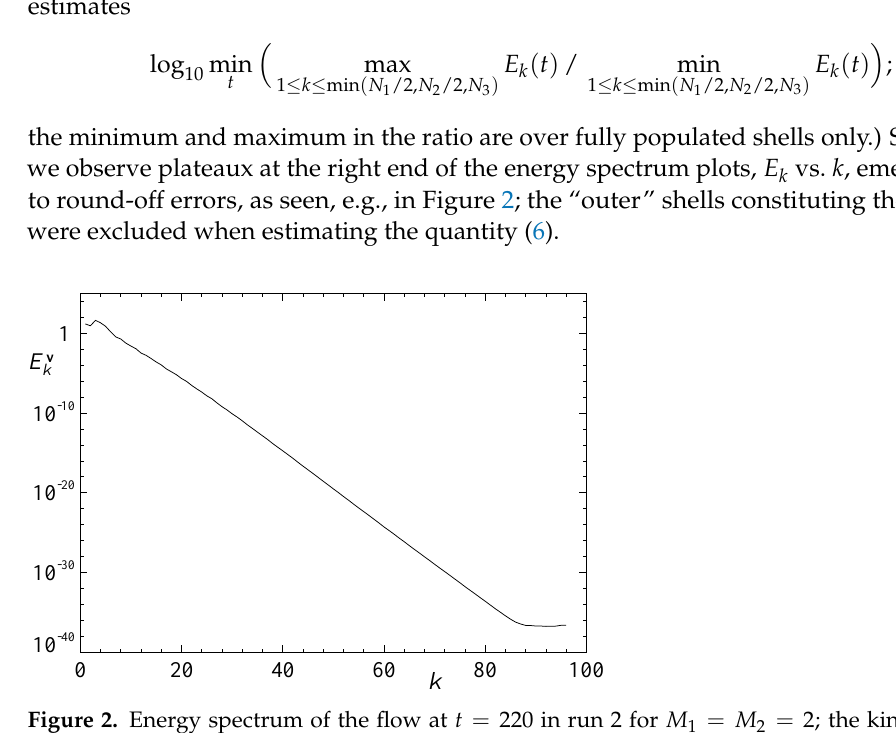
Figure 2. Energy spectrum of the flow at t = 220 in run 2 for M 1 = M 2 = 2; the kinetic energy distribution E v over shells C k is shown for fully populated shells k